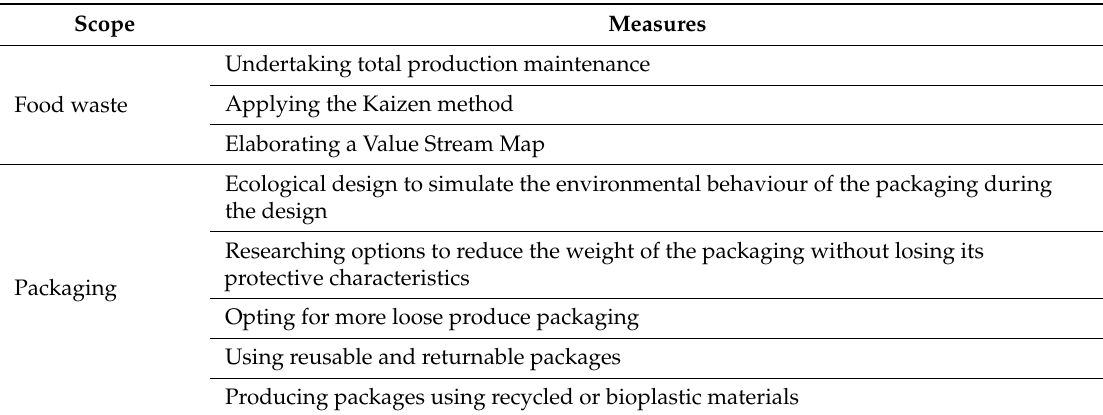
Table 2. Best environmental management practices in the food and drinks production